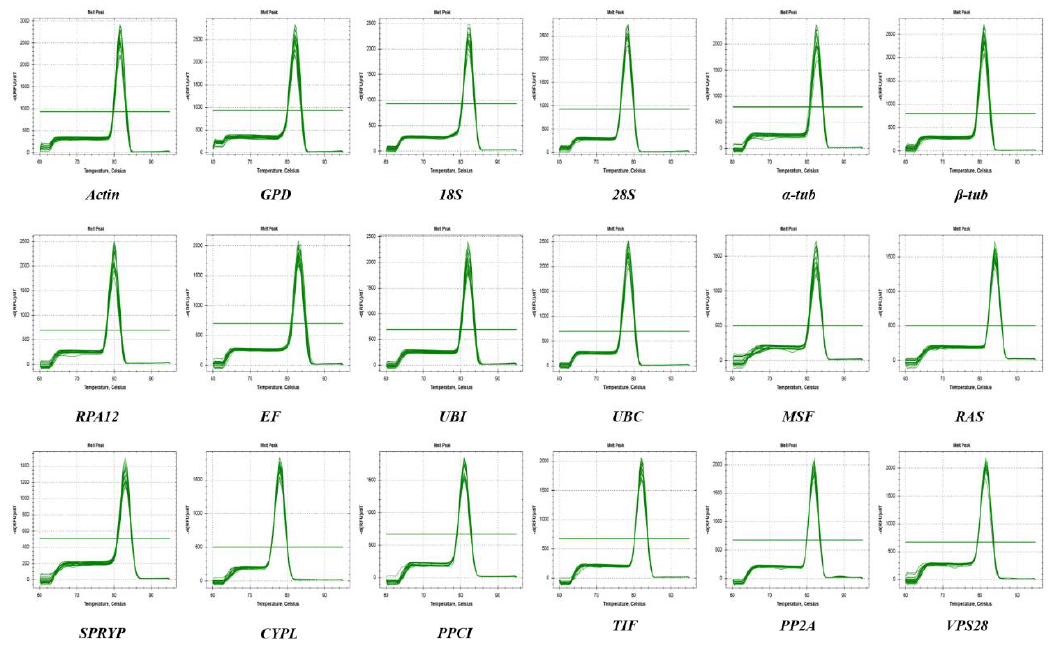
Figure 1. Amplification and dissolution curves of eighteen candidate reference genes.